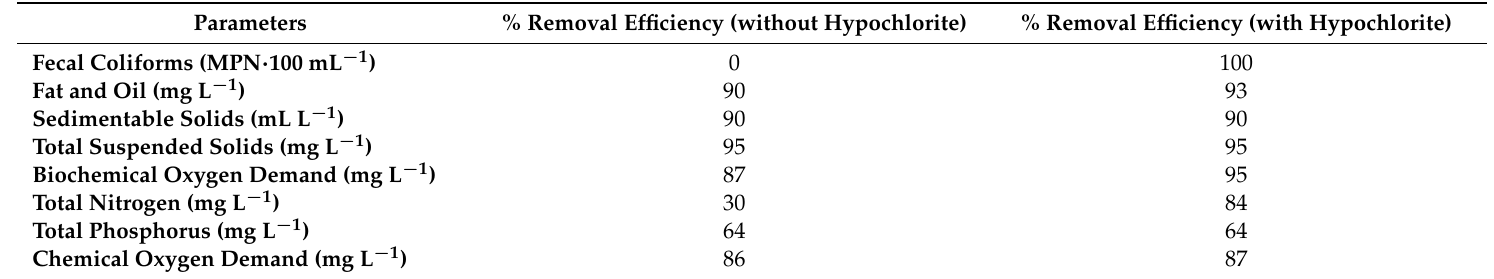
Table 2. Removal efficiency of contaminants by the MFCSS using hypochlorite as a final polishing step.